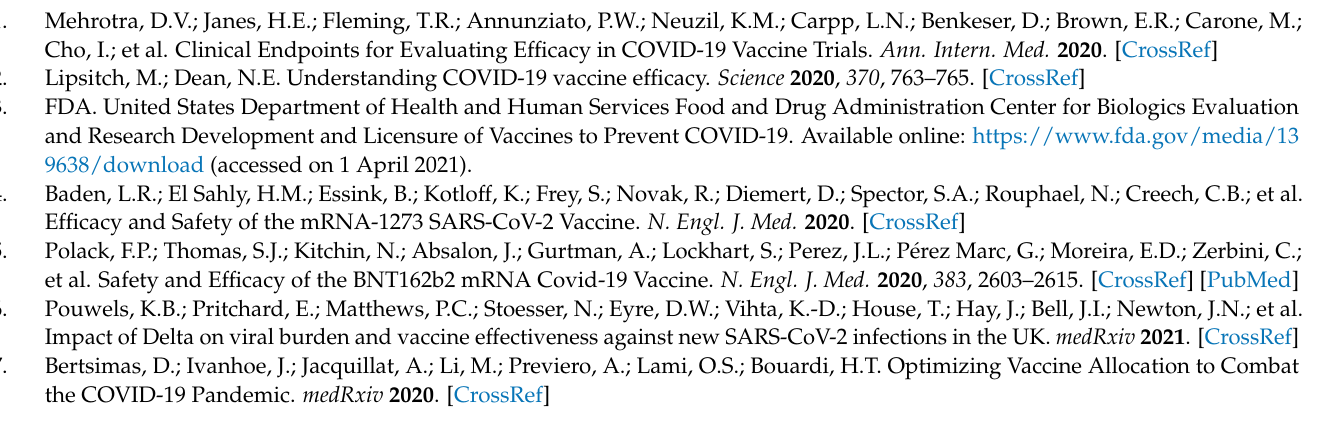
Figure S3: Conceptual basis for reduction in viral load lowering transmission. Figure S4: Small reduction in peak viral load due to vaccinations would translate to significant VE INF . Table S1: Parameters and ranges used in the analysis. Table S2: Monthly parameter fits. Table S3. Monthly Table S5. King County age pyramid based on data from